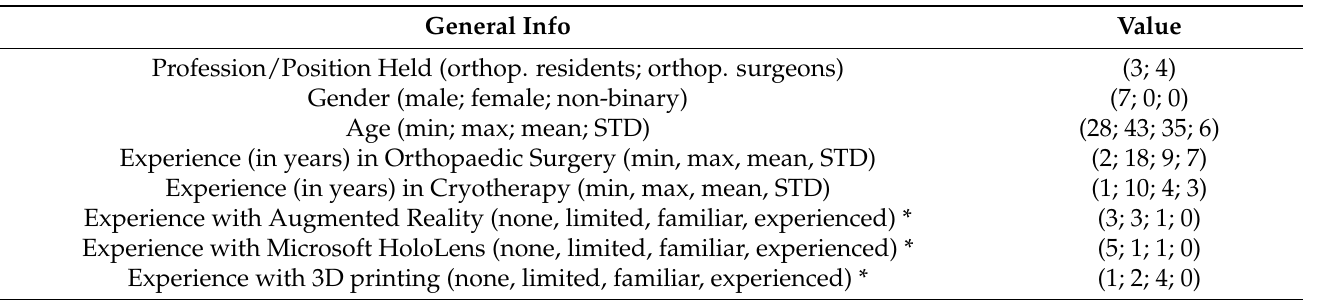
Table 1. Demographics of participants in the user study.